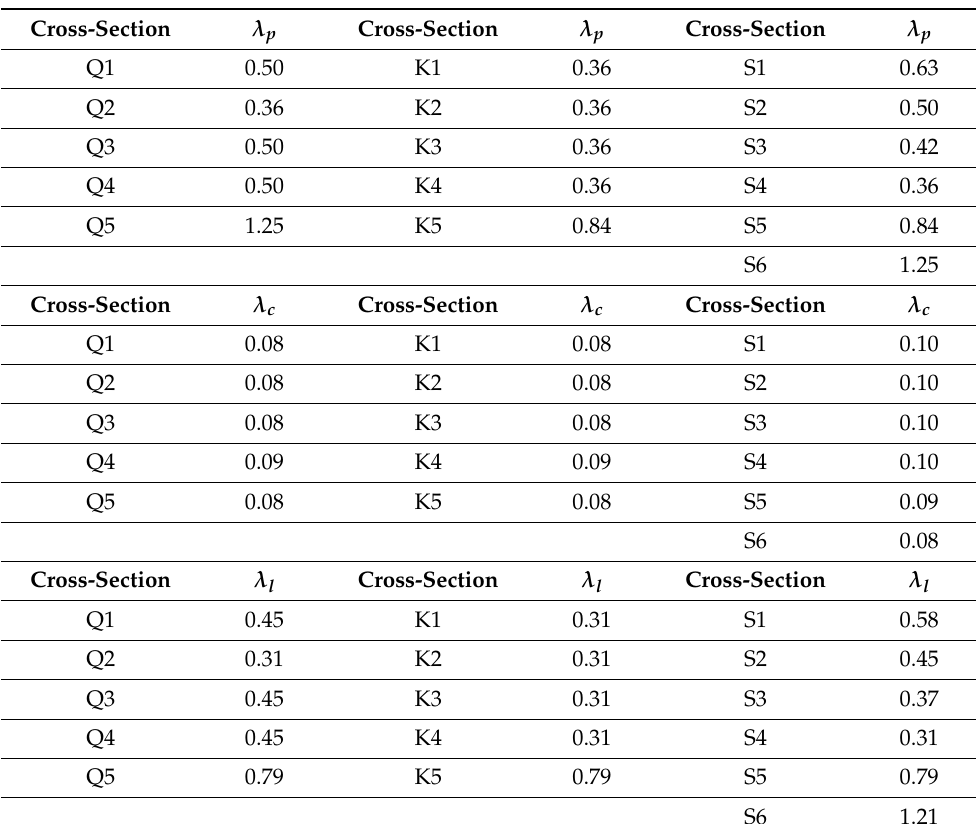
Table 4. CSM ( λ p ) and DSM ( λ c , λ l ) slenderness values for each